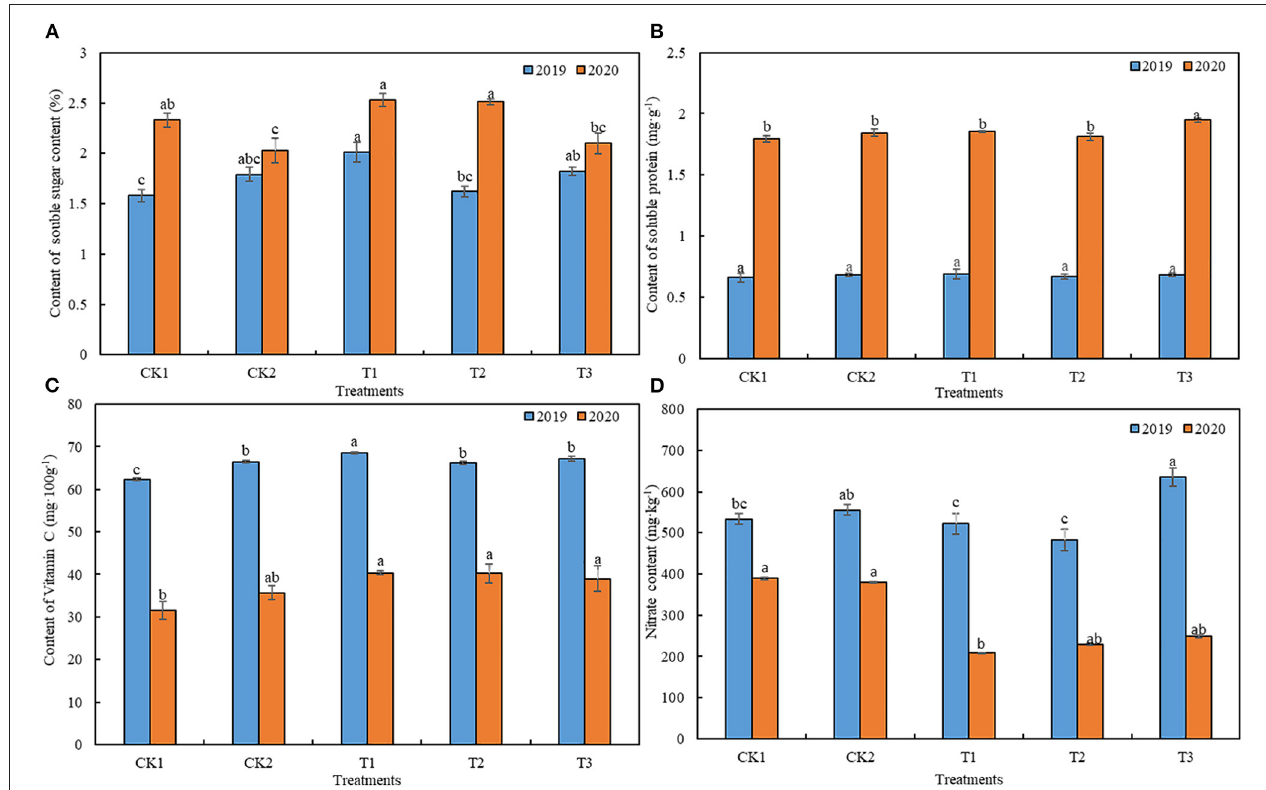
FIGURE 2 | Effects of different ground mulching patterns on (A) soluble sugar, (B) soluble protein, (C) vitamin C, and (D) nitrate contents in loose-curd cauliflower heads. Values are expressed as mean ± SE ( n = 3). Different letters denote significant differences ( p < 0.05). CK1, CK2, T1, T2, and T3 are defined in Figure 1 .